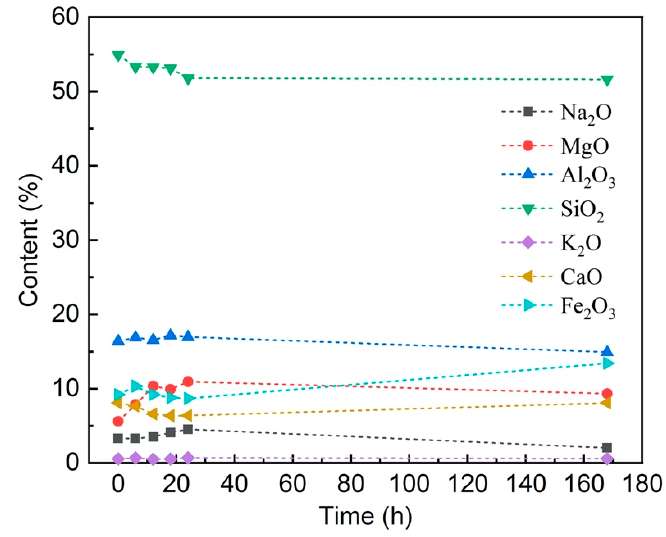
Figure 4. Energy-dispersive X-ray spectroscopy (EDS) analysis of basalt fiber surface after soaking in 85 °C seawater solution for different times (wt%). Dash lines are the guide of eyes.